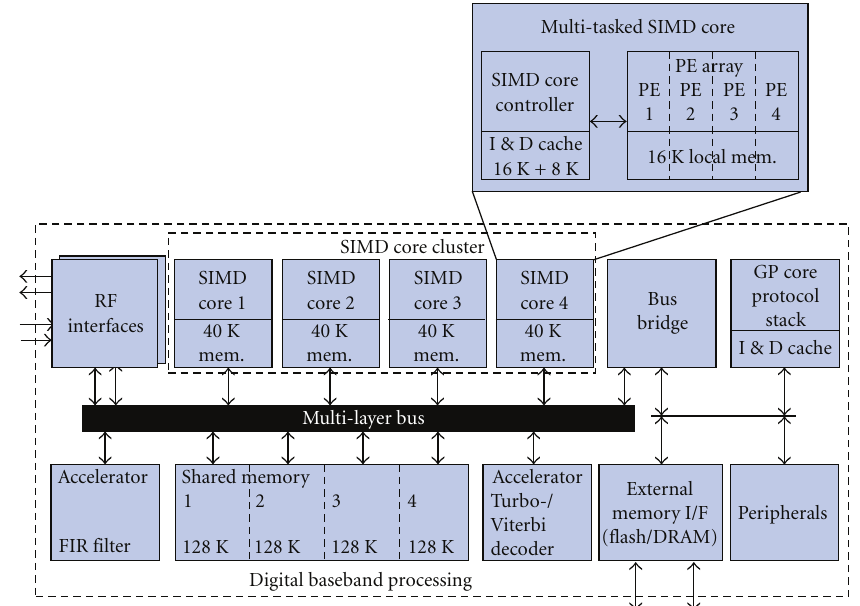
Figure 4: The SDR baseband platform